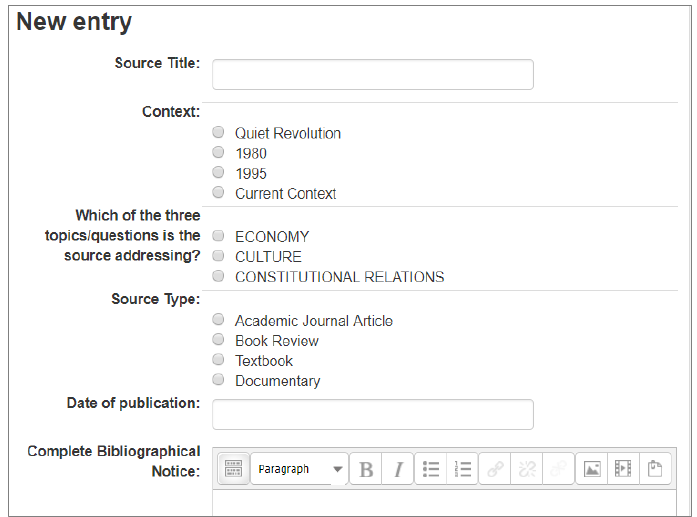
Figure 4. Entering data in the Moodle database